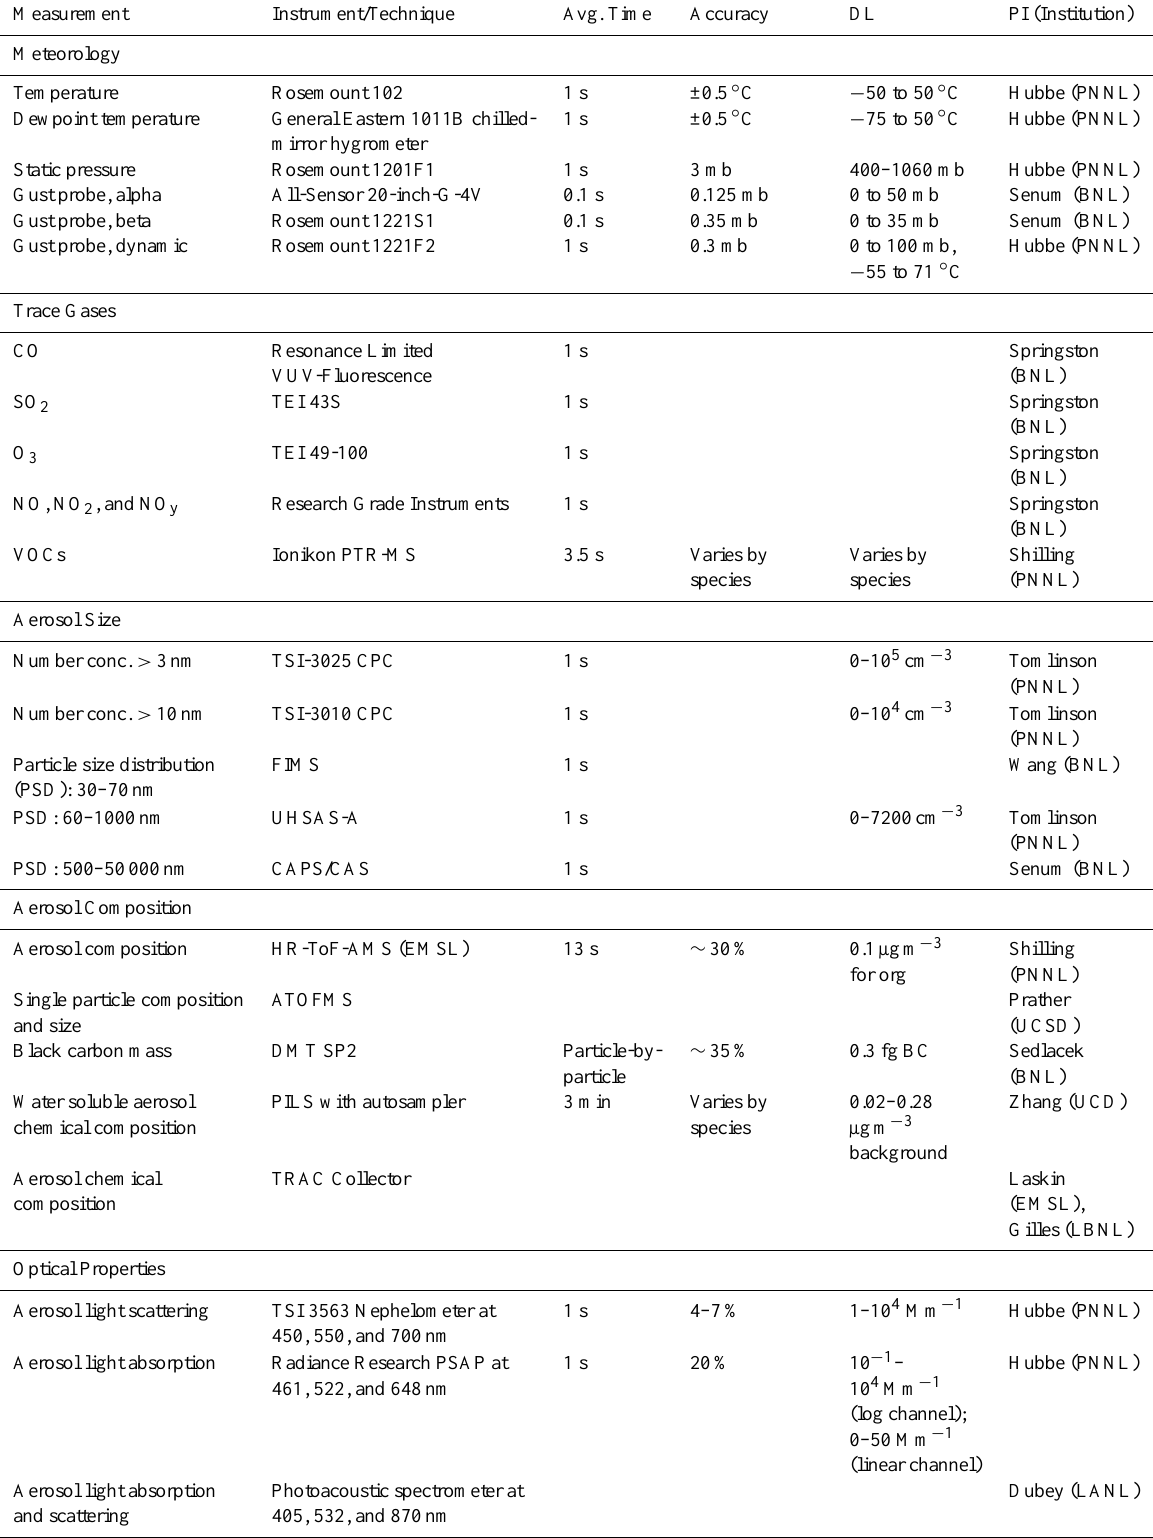
Table 2. Measurements and Instruments aboard the DOE G-1 Aircraft during CARES 2010.